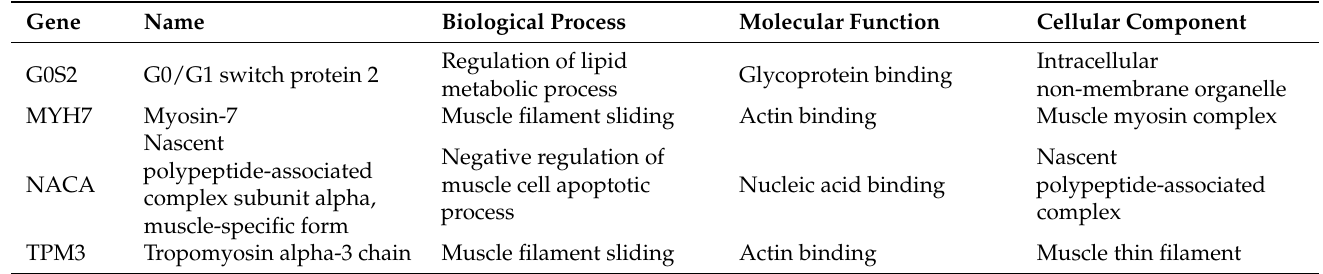
Table 2. Classification (Gene Ontology) of potential muscle biomarker genes for gestational diabetic- induced myopathy (GDiM).